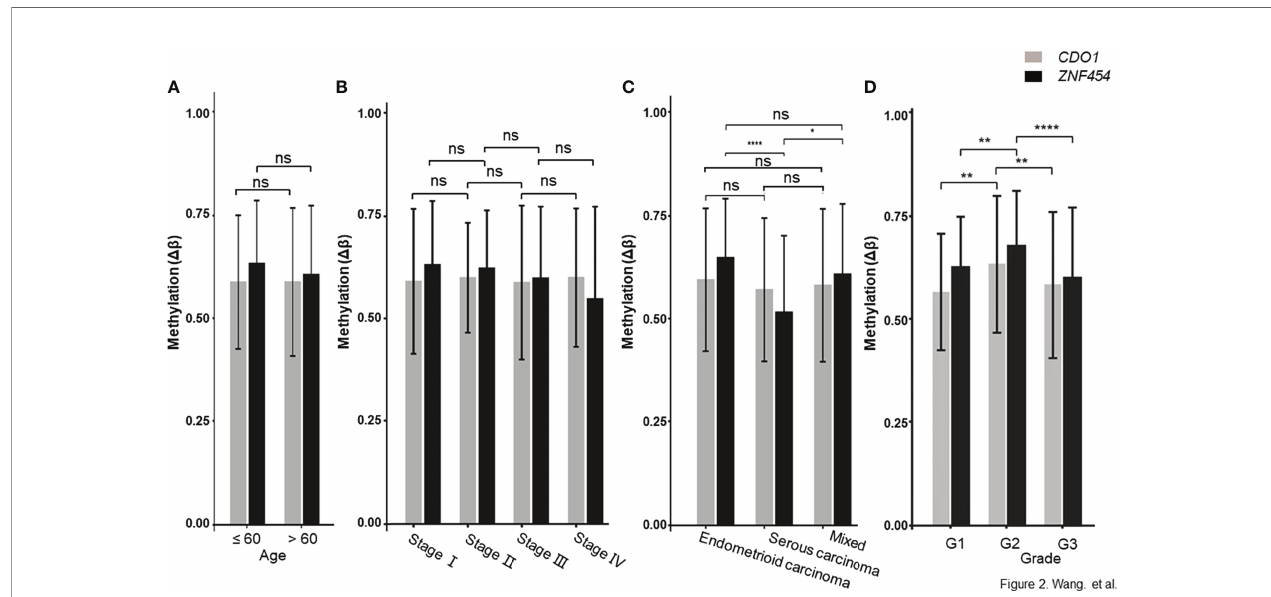
FIGURE 2 | DNA methylation level between different age groups, stages and pathologic types. (A) CDO1 and ZNF454 methylation levels between women aged ≤ 60 and >60. (B) CDO1 and ZNF454 methylation levels between different stages. (C) CDO1 and ZNF454 methylation levels between different pathological types. (D) CDO1 and